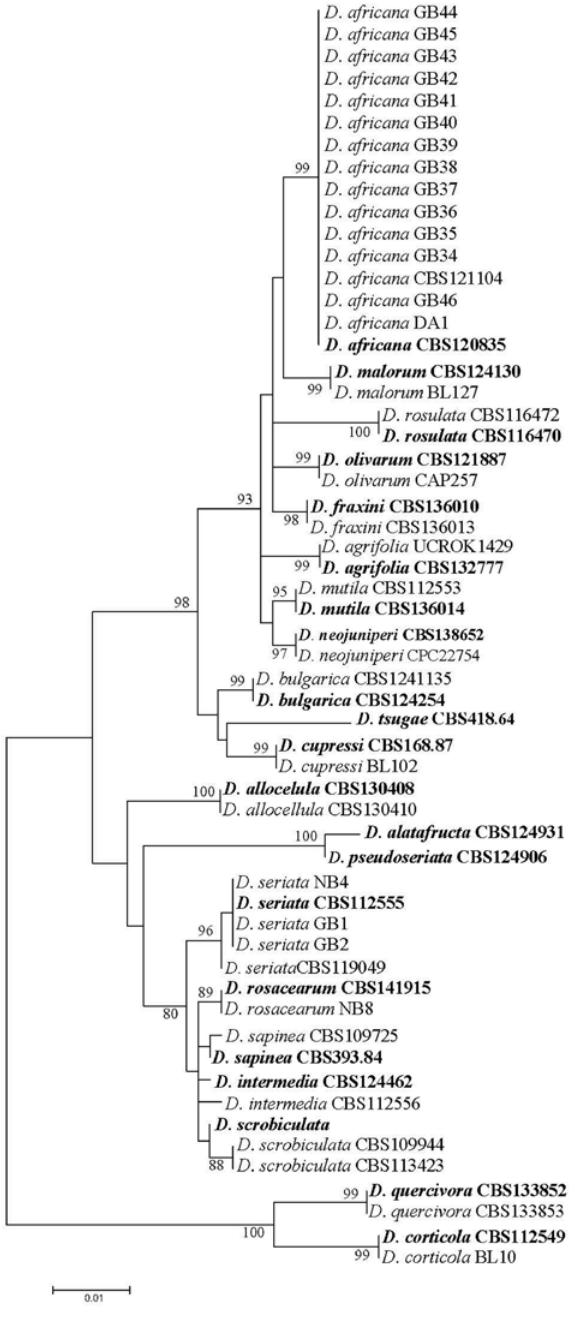
Figure 3. Maximum Likelihood tree of combined ITS and tef1-α sequence data for Diplodia species. The tree was drawn to scale, with branch lengths measured for the number of substitutions per site. Bootstrap support values ≥ 70% (1,000 replicates) are given at the nodes. The type species are in